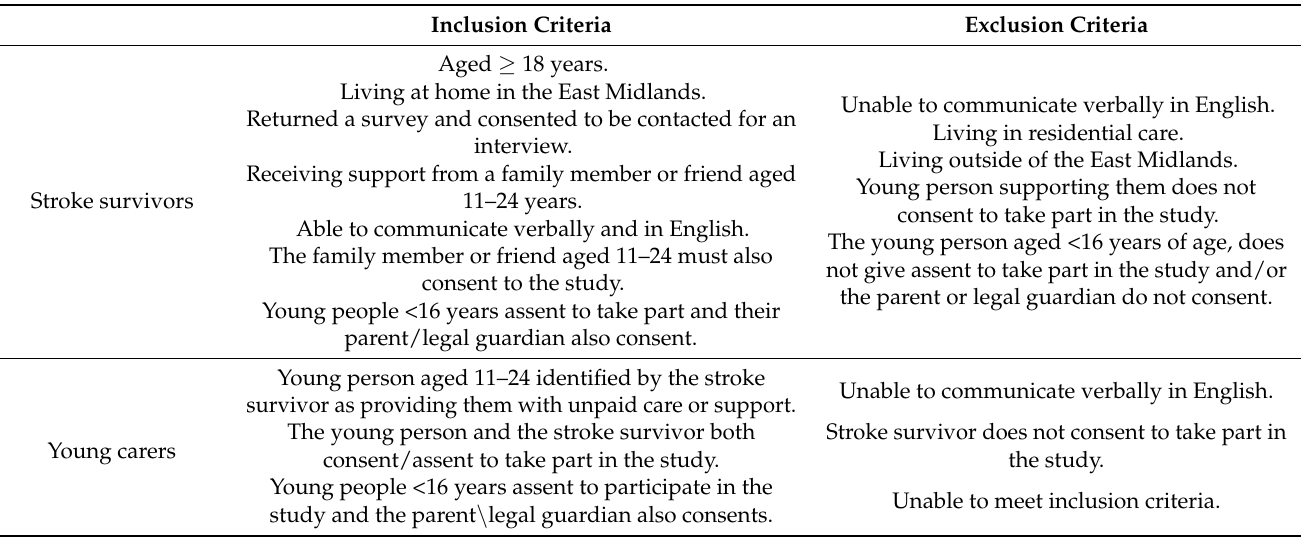
Table 1. Inclusion and exclusion criteria for